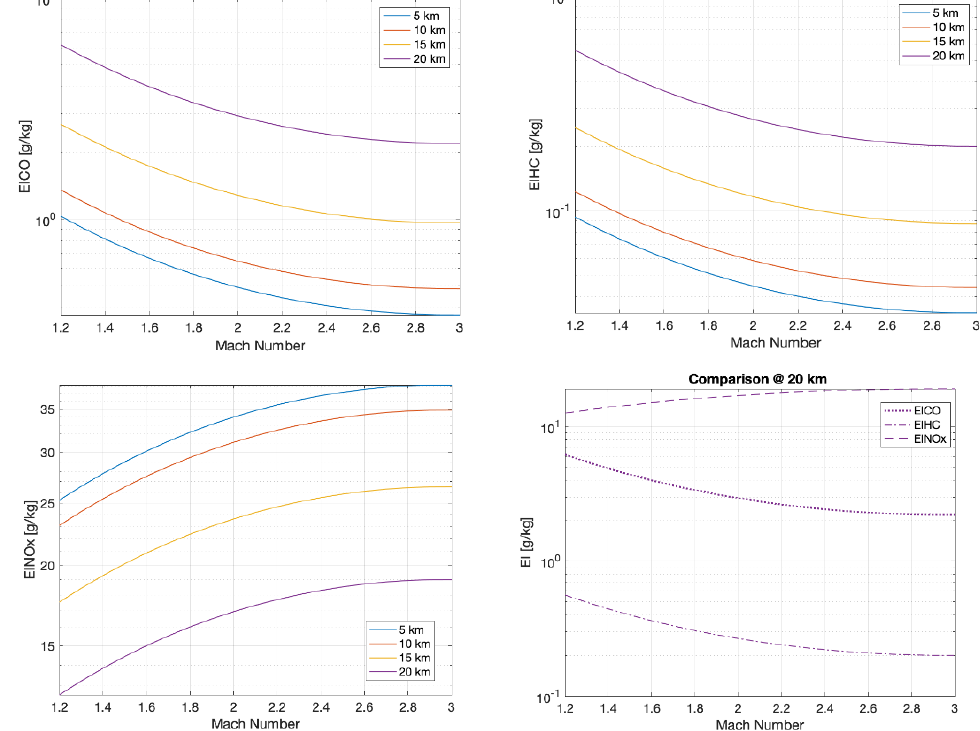
Figure 7. Emission indexes variation as function of cruise Mach numbers at different altitudes.